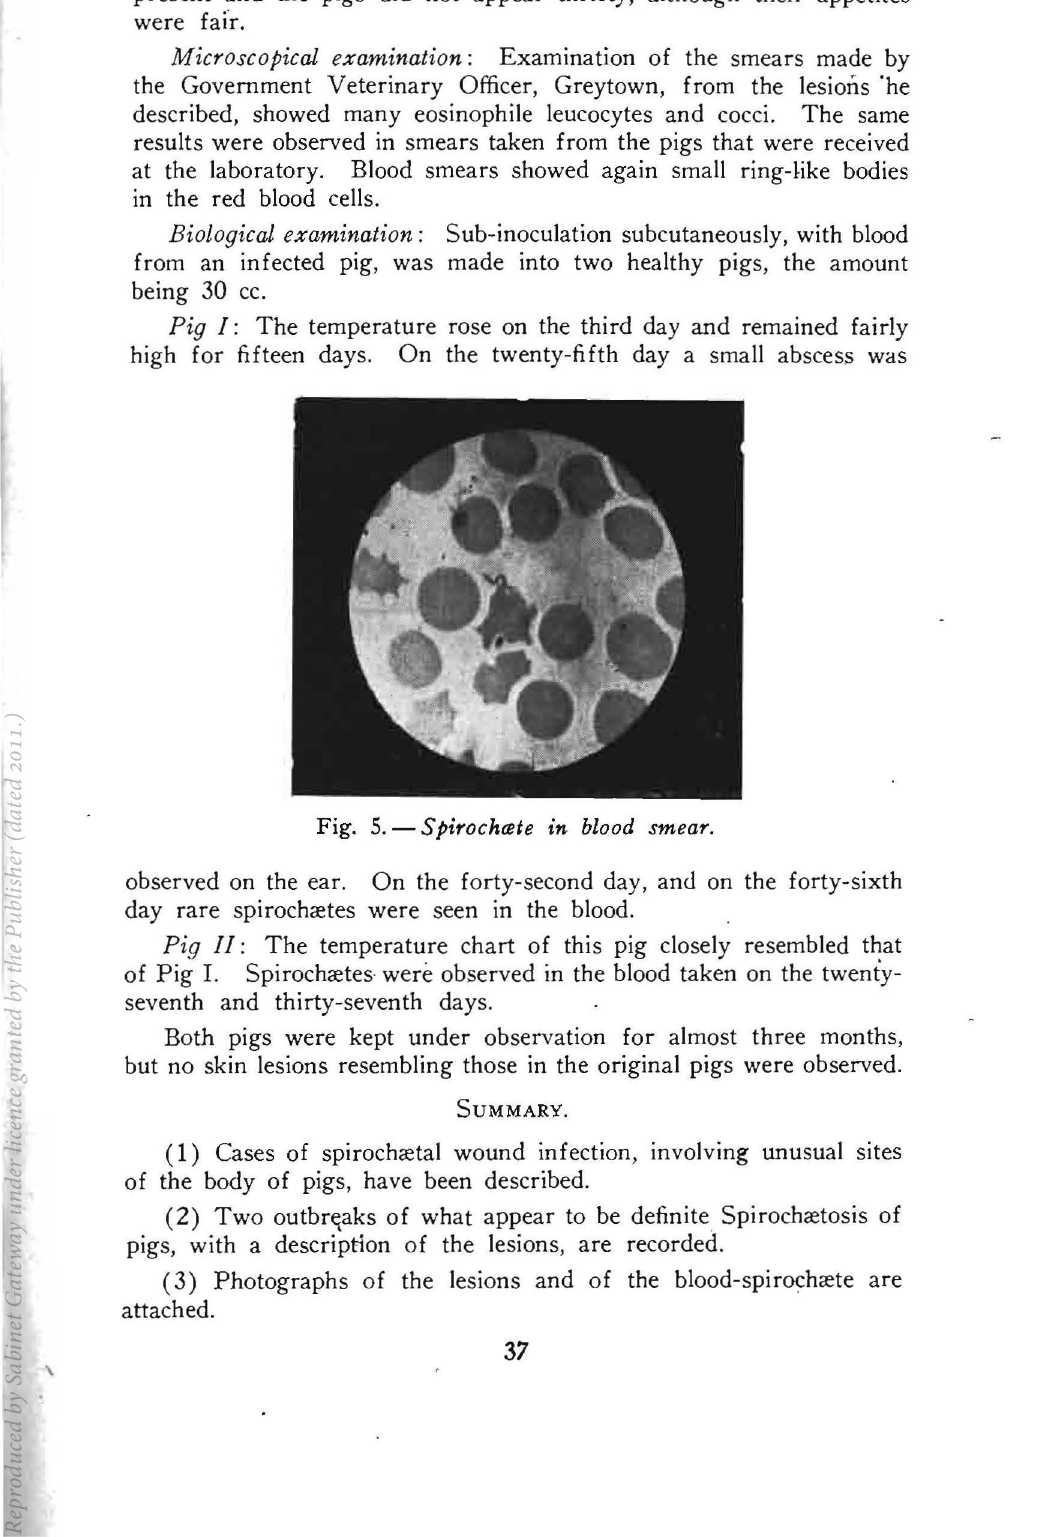
Fig. 5. - S pirochl1!te in blood